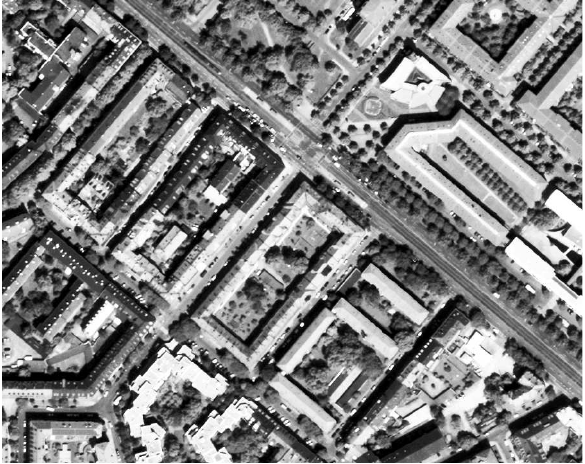
Figure 2: High resolution Pan-chromatic image